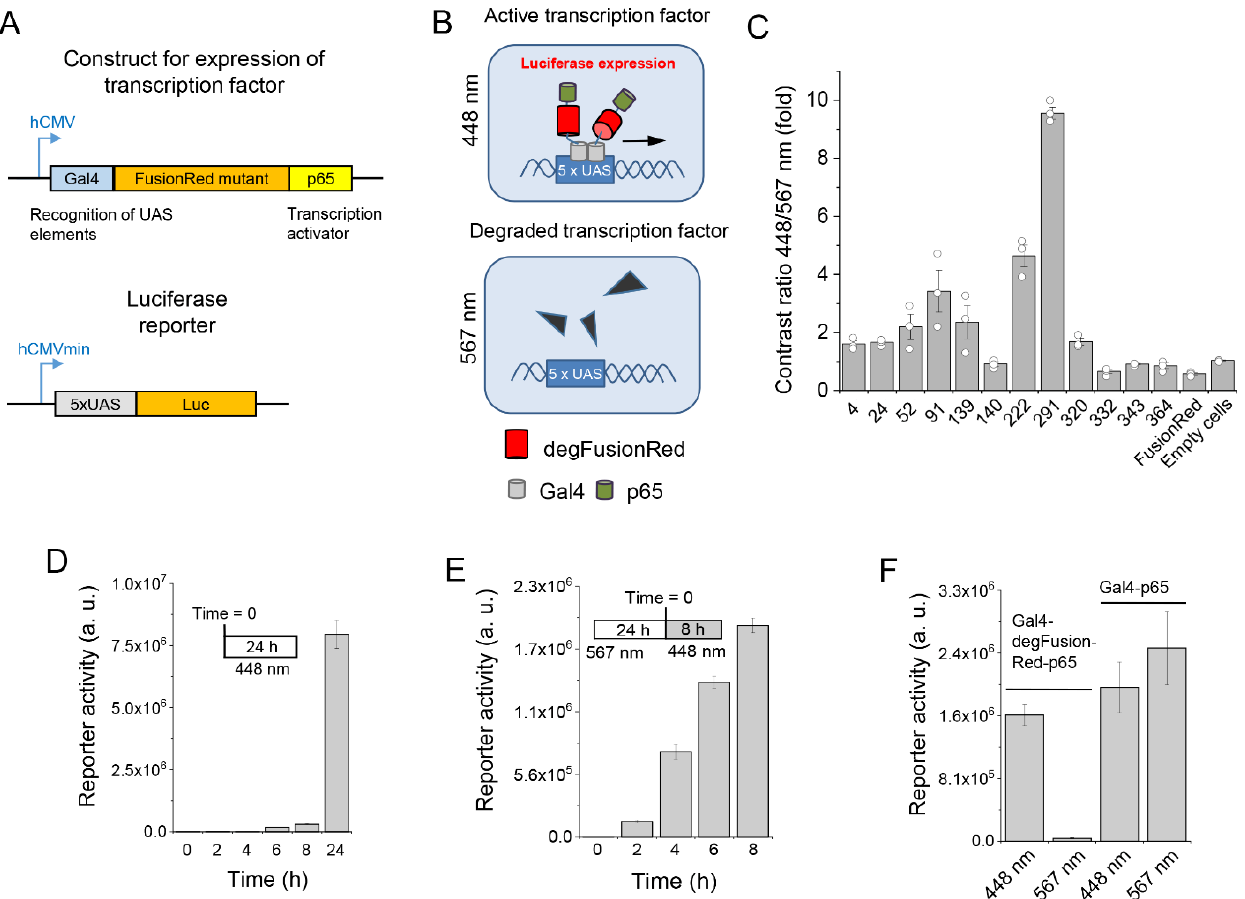
Figure 1. Screening of FusionRed mutants via light-controlled transcription. ( A ) Genetic constructs for the expression of FusionRed mutants in HEK293 cells. FusionRed gene is placed in the frame between Gal4 and p65 domains under the human CMV promoter (top). The Gaussia luciferase gene is placed under the control of the human CMV minimal promoter and 5 × UAS operator region (bottom). ( B ) Schematics of Gal4-degFusionRed-p65 light regulation in mammalian cells. Under 448 nm light, two Gal4 domains of the Gal4-degFusionRed-p65 transcription factor recognize 5 × UAS elements Gal4 ‐ degFusionRed ‐ p65 (bottom). ( C ) Comparison of 12 selected clones by 448 nm/567 nm contrast